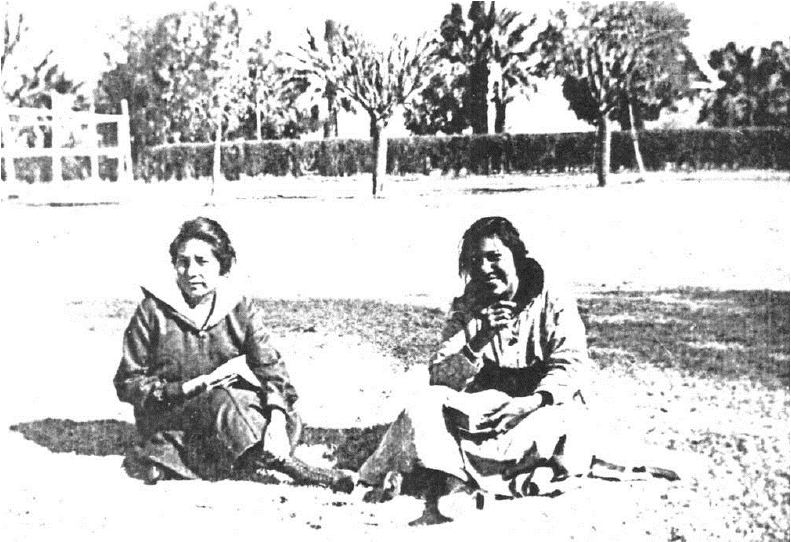
Figure 9. Doye Cleveland and Nettie Odlety, 1916. Photograph by Parker McKenzie. Parker McKenzie Collection. Courtesy of the Oklahoma Historical